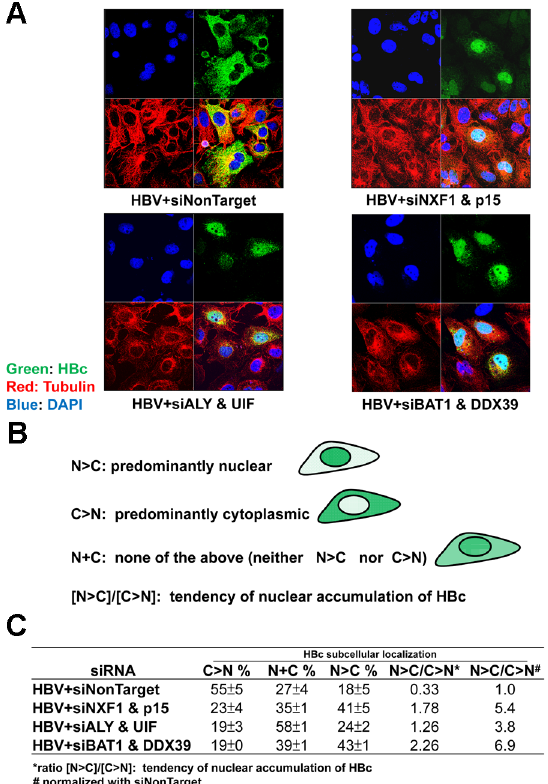
Figure 4. Perturbation of the TREX complex and NXF1-p15 nuclear export machinery by siRNA treatments can result in accumulation of HBc protein in the nucleus by IFA. A) An HBV genome and siRNAs were co-transfected into HuH-7 cells. Transfected culture was fixed 40 hrs post-transfection before IFA. A negative control by siNonTarget treatment exhibited a cytoplasmic predominant pattern (C . N) of HBc (upper left). In contrast, siRNA treatments against NXF1 and p15 (upper right), ALY and UIF (lower left), as well as BAT1 and DDX39 (lower right), induced nuclear accumulation of HBc protein. B) Three different subcellular distribution patterns of HBc are cartoon illustrated. N . C: nucleus predominant pattern; C . N: cytoplasm predominant pattern; N + C: present in both nucleus and cytoplasm, ratio N . C/C . N: tendency of nuclear accumulation. C) Quantitative results of the IFA assay in A) were summarized in the Table. Approximately 100–150 HBc-positive cells were scored in each transfection experiment. The data shown here represent an average from at least three independent transfections.